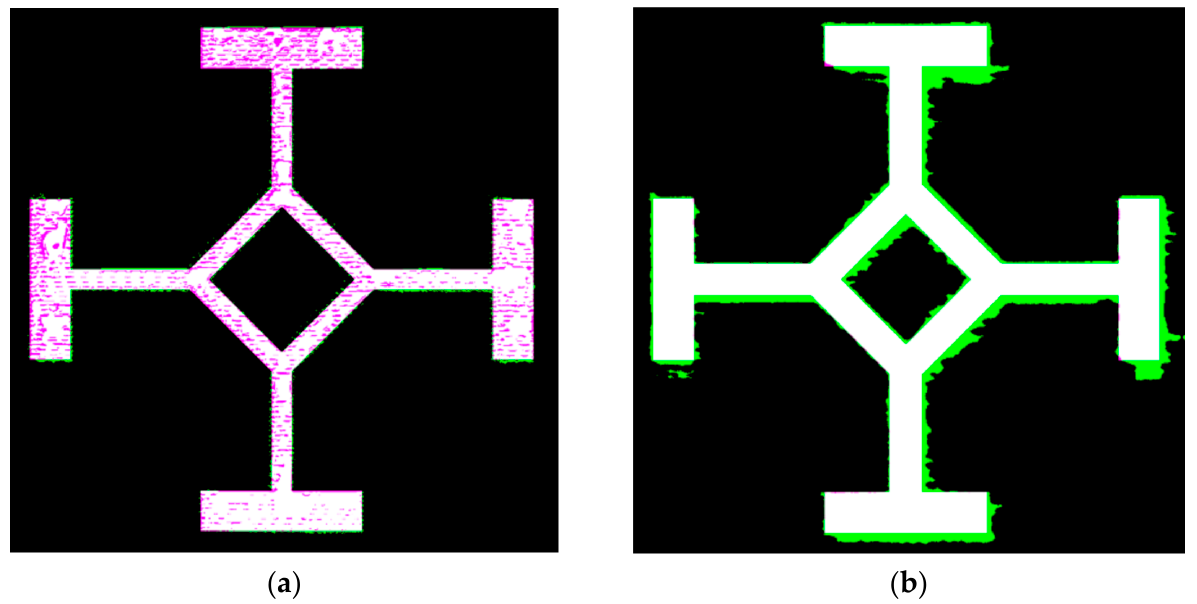
Figure 6. Examples for underwetting ( a ) displayed in magenta areas and overwetting ( b ) displayed